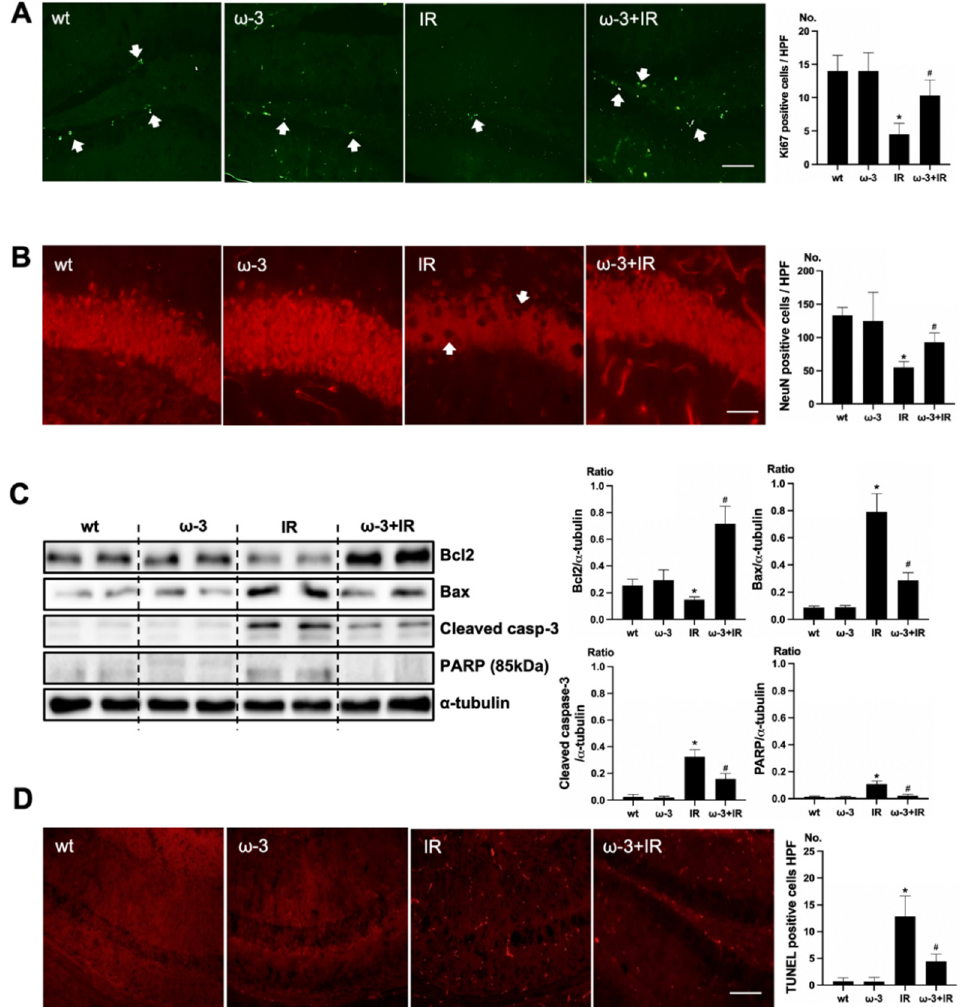
Figure 3. Effects of oral administration ω -3 PUFA on brain damage in ischemia-reperfusion (IR) kidney. ( A ) Representative immunofluorescence stain of subgranular zone of the hippocampal DG of the brain section: Immunofluorescent staining was performed using Ki67 in the brain. High power field (HPF), original magnification, 200 × . Scale bar = 50 µ m. ( B ) Representative immunofluorescence stain of subgranular zone of the hippocampal DG of brain section: Immunofluorescent staining was performed by using NeuN in the brain. Original magnification, 400 × . Scale bar = 200 µ m. ( C ) Representative Western blot of brain lysis: The brain of ω -3 PUFA-treated uremic mice showed decreased Bax, cleaved caspase3 expression, and increased Bcl2 expression compared to the brain of uremic mice. Additionally, PARP (85 kDa) expression was also reduced in the brain of ω -3 PUFA- treated uremic mice compared to the brain of uremic mice. ( D ) Representative TUNEL stain of the subgranular zone of the hippocampal DG of the brain section. Original magnification, 200 × . Scale bar = 50 µ m. * p < 0.001 vs. wt, # p < 0.001 vs. IR. Bar represents mean ± S.D. (wt, wild-type sham; ω -3, ω -3 PUFA oral administration sham; IR, IR renal injury in wild-type mice; ω -3+IR, IR renal injury in ω -3 PUFA oral administration